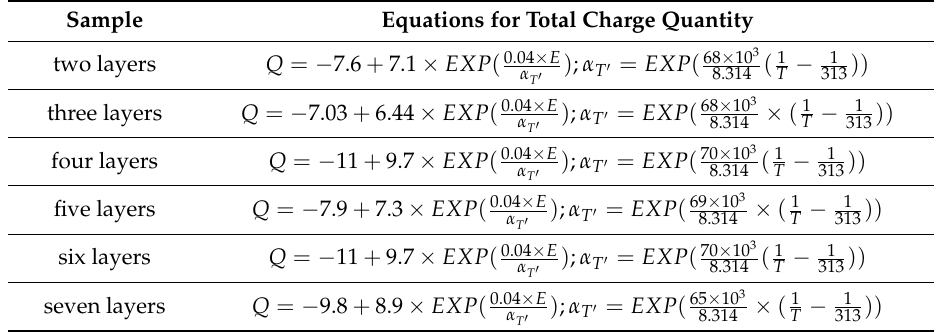
Table 7. Calculation equations for the total charge quantity under the combined action of electrical field strength and temperature for multi-layer oil-paper